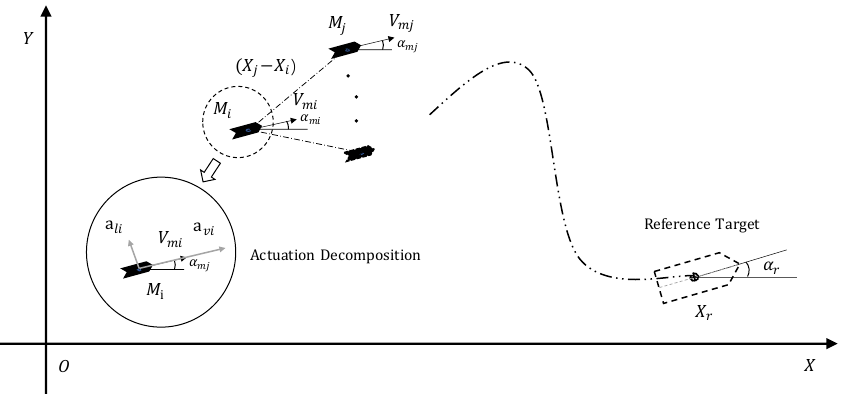
Figure 1. Engagement